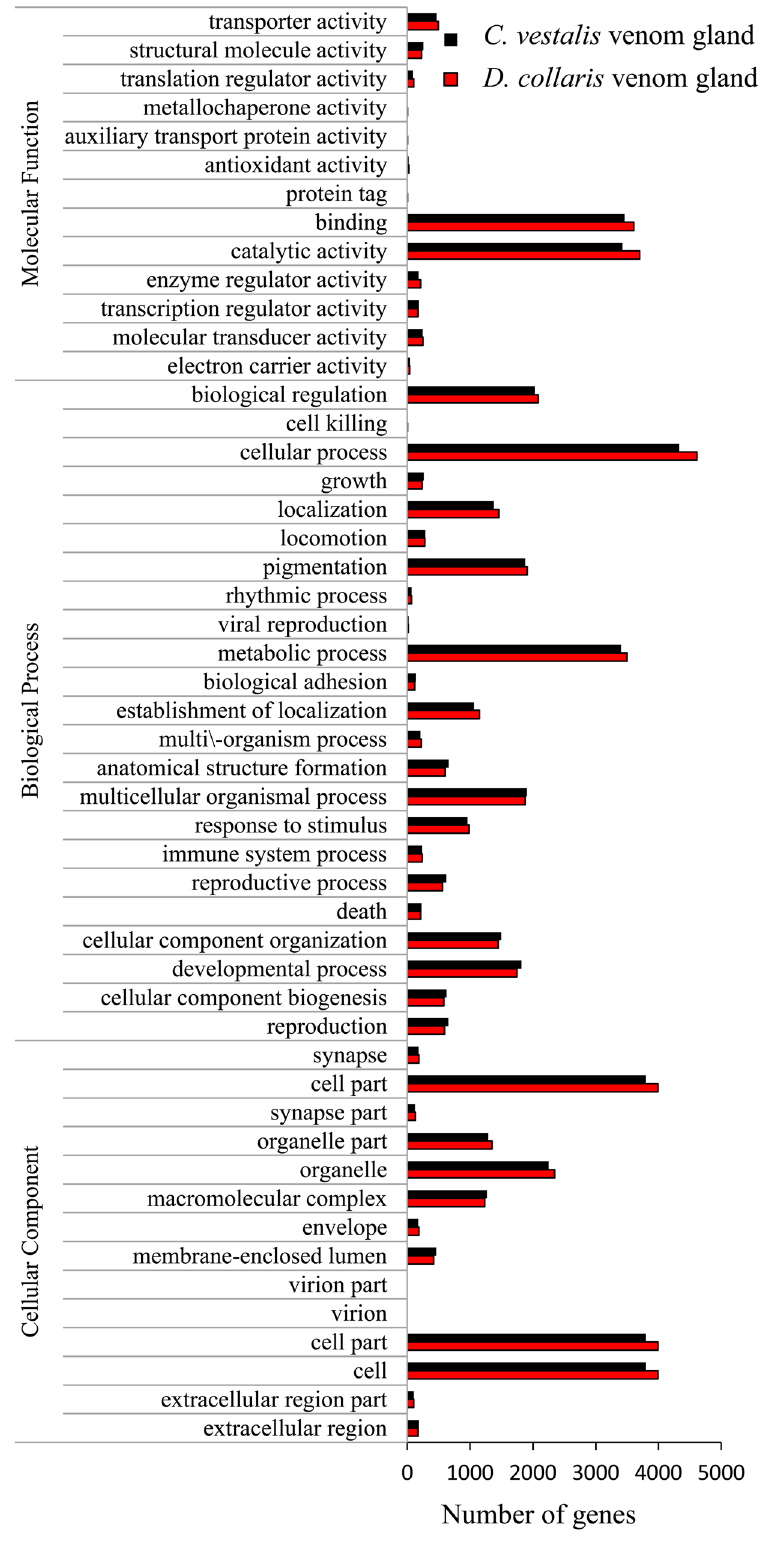
Figure 3. GO term distribution of venom gland genes at level